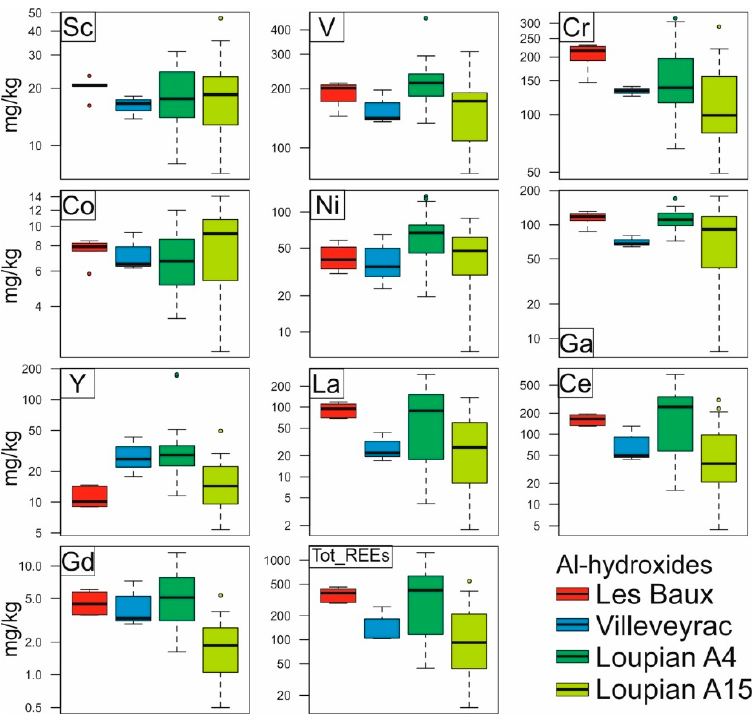
Figure 4. Boxplots reporting the compositions (mg/kg) of selected elements in the analyzed Al-hydroxides. Individual LA-ICP-MS analyses are given in Table S2.